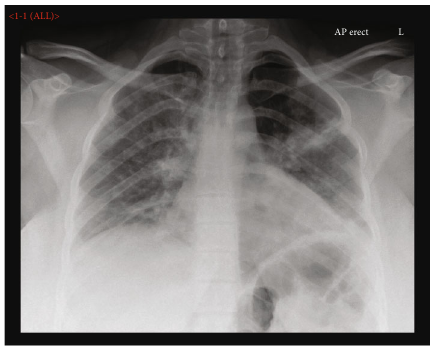
Figure 1: Chest X-ray on admission to the hospital prior to intubation.